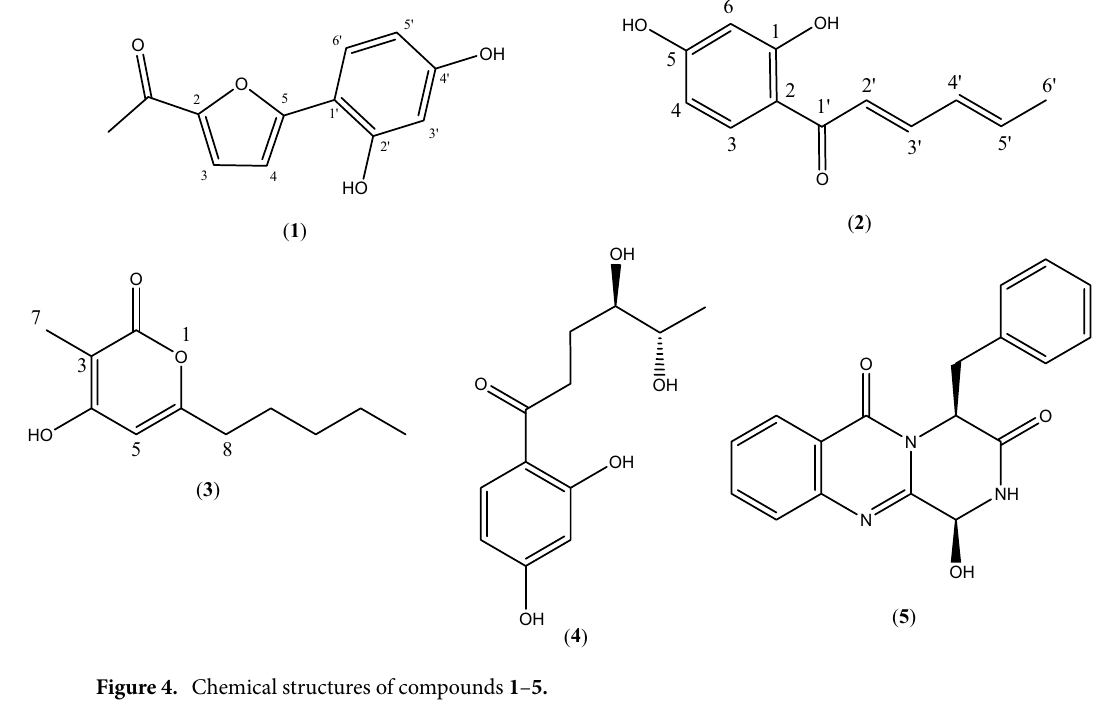
Figure 4. Chemical structures of compounds 1 –